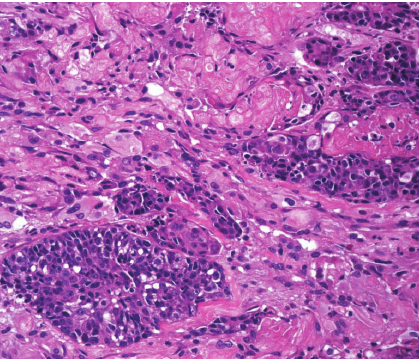
Figure 3: The cytoplasm of the shadow cells is fine and granular, eosinophilic, with yellowish (honey-like) shade. Some shadow cell clusters were isolated in the inflamed stoma (hematoxylin and eosin).